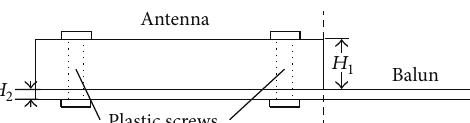
is on the top side of layer #2 with the width of 𝑊 50 , whose characteristic impedance is 50 Ω . The CPW is on the bottom side with the same sizes of the antenna CPW feedline. The electromagnetic wave fed by the microstrip will be coupled by proximity manner by the ring of the microstrip line and